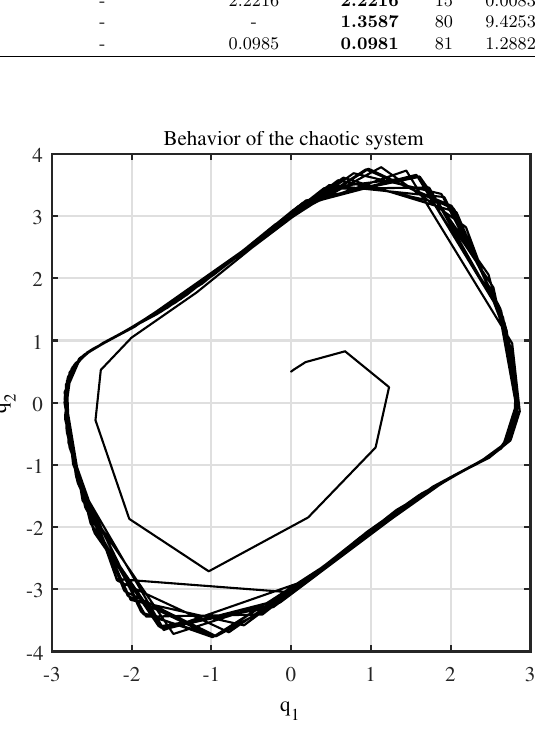
Figure 1: Behaviour of the first chaotic